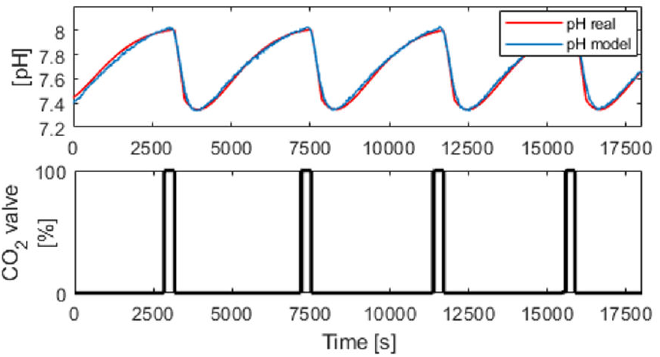
Figure 6. Thin-layer reactor model validation during nighttime period. First graph represents the evolution of the real pH (blue) and the estimated pH (red). Second graph represents the valve opening, input for the model (black). December 2020.